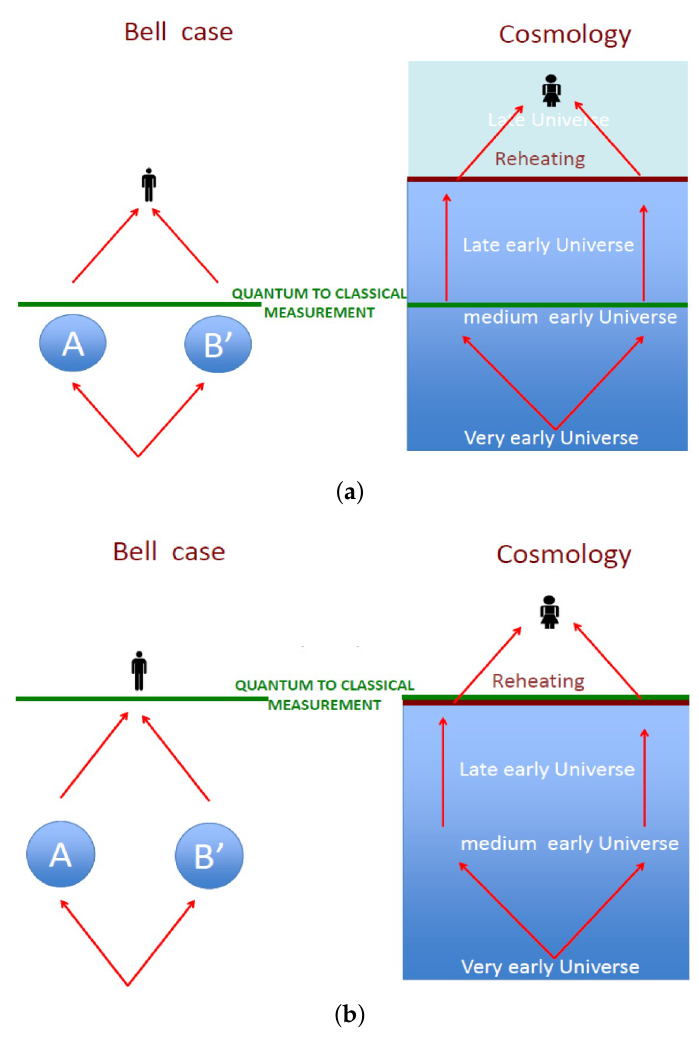
Figure 2. ( a ) Successful vs. ( b ) Unsuccessful setup for Bell’s inequality violation in Quantum Mechanics and Cosmology